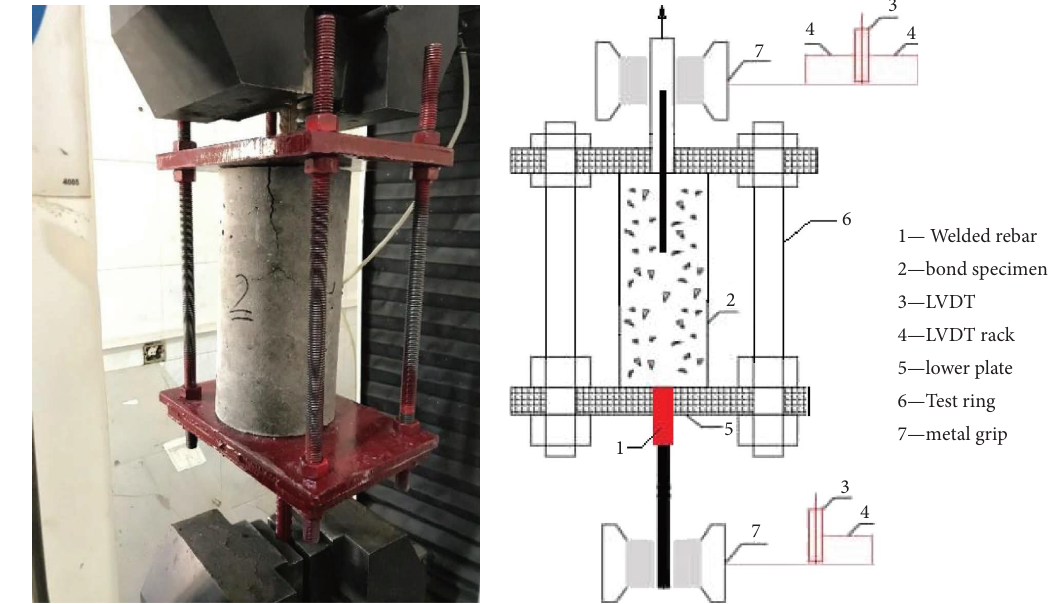
Figure 4: Te pull-out test setup device [1]. Table 1: Mechanical properties of the concrete mix design.